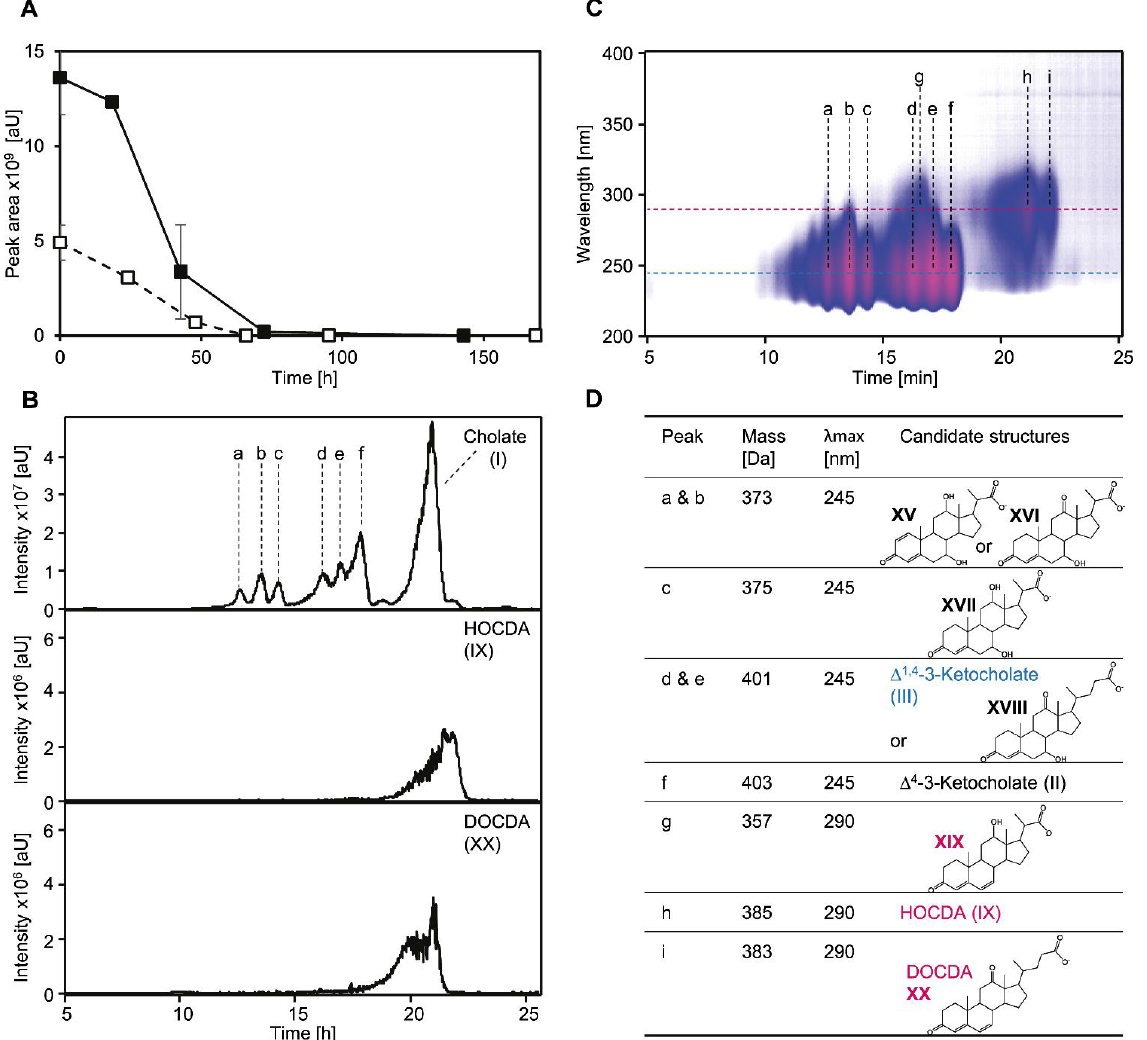
Figure 8. ( A ) Degradation of 1 mM cholate (solid line, filled squares) and 1 mM HOCDA (IX in Figure 1, dotted line, open squares) in soil slurry microcosms with soil samples from agriculturally used fields in the Münsterland region. Error bars indicate standard deviation ( n = 3). ( B ) MS base peak chromatogram of the extracted supernatant of a soil slurry incubated with 1 mM cholate for about 48 h (top) as well as extracted ion chromatograms with the m / z values of HOCDA (383 Da for [M-H] − 1 , middle) and DOCDA (XX, 385 Da for [M-H] − 1 , bottom). Samples were measured in negative MS mode. ( C ) 3D UV chromatogram of the extracted supernatant of a soil slurry incubated with 1 mM cholate for about 48 h and structure suggestions for several intermediates assigned to peaks. Intensity is shown as a heat map. Red indicates highest absorption. ( D ) Candidate structures for peaks a-i found in ( B , C ). Masses and absorption maxima ( λ max ) were determined by HPLC-MS measurements. Structure suggestions are based on molecular masses, absorption spectra, and retention time. Candidate structures belonging (blue) to the ∆ 1,4 -pathway, (red) to the ∆ 4,6 -pathway, and (black) potentially occurring in both pathways. When structures could not be assigned unambiguously, two possible structures are depicted. XV: 7,12-Dihydroxy-3-oxo-pregna-4-ene-carboxylate, XVI: 7-Hydroxy-3,12-dioxo-pregna-4-ene-carboxylate,